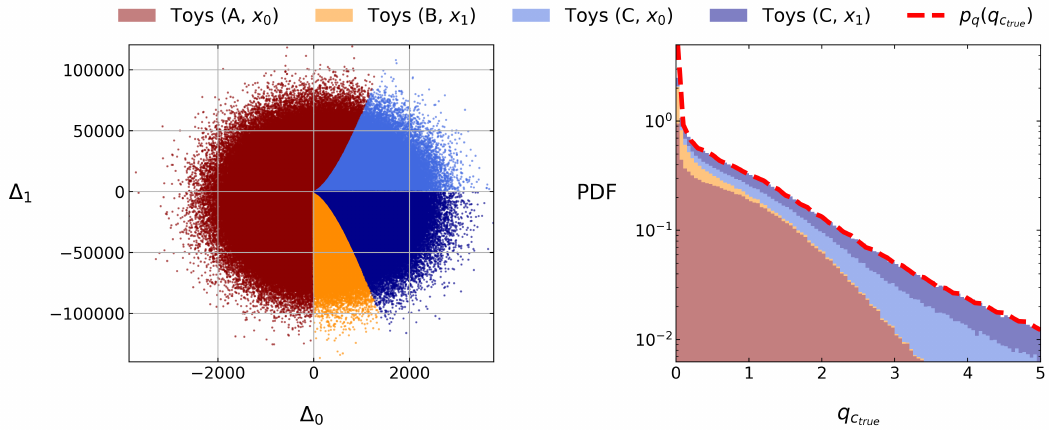
) -plane. Right: stacked distribu- , ∆ 0 1 along with the modelled c true